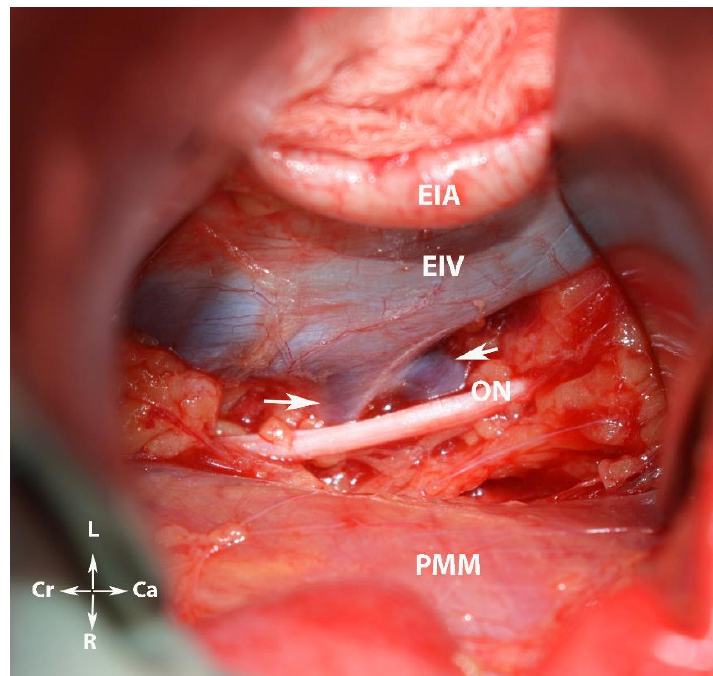
Figure 13. The ALV or ILV draining into the EIV as a common trunk (white arrows). EIA—external iliac artery; EIV—external iliac vein; ON—obturator nerve; PMM—psoas major muscle; Cr—cranial; Ca—caudal; L—left; and